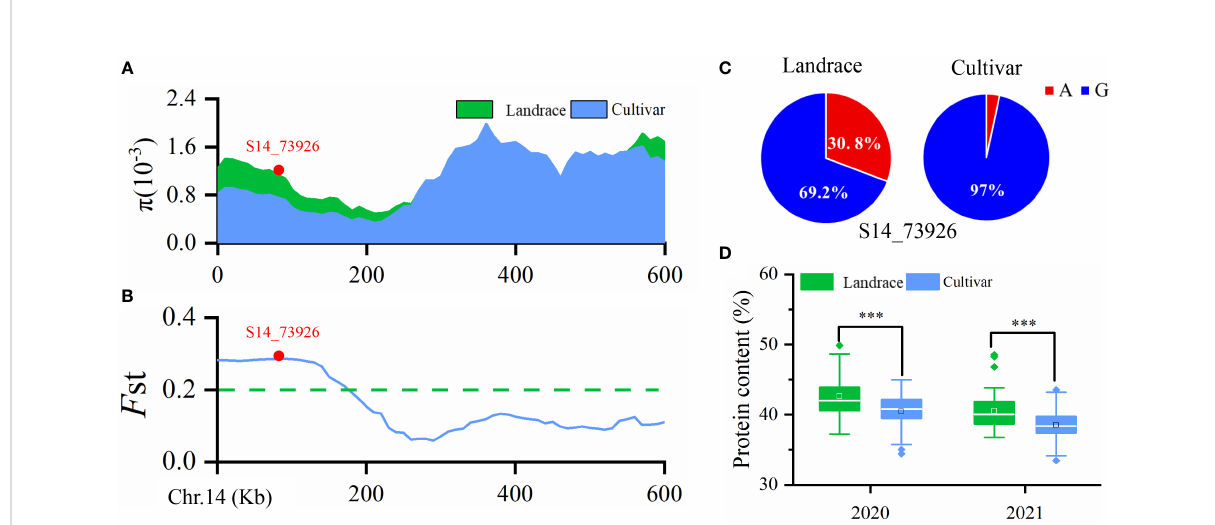
FIGURE 3 (A) Nucleotide diversity ( p ) values in landraces and improved cultivars. (B) Fixation index ( F ST ) plot of landraces and cultivars in the 600-kb genomic regions surrounding the lead SNP, S14_73926, in qPC-14-1. (C) Allele frequencies of S14_73926 in landraces and cultivars. A and G are